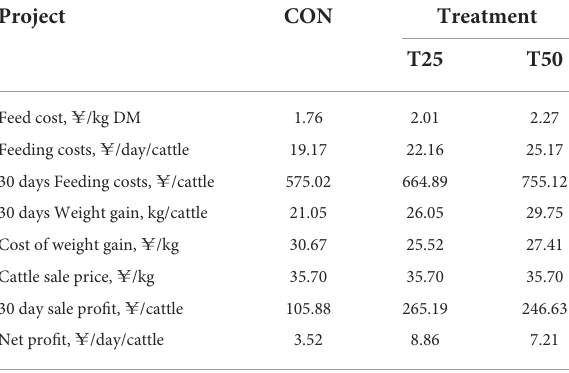
TABLE 4 Economic benefits of different proportions of FPR.